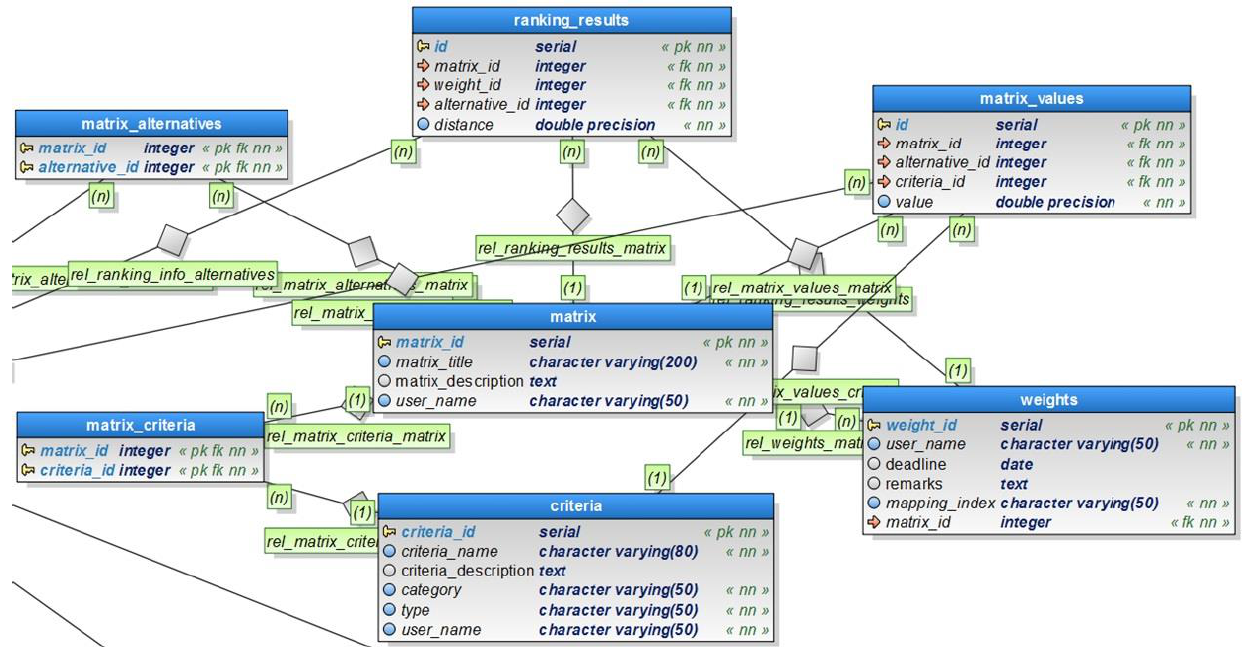
Figure 6. Data Model of the Decision Analysis